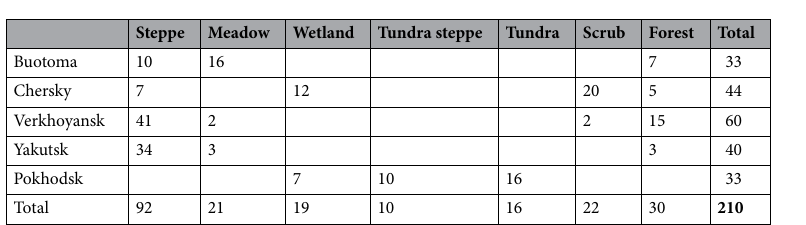
Table 2. Overview on the number of plots in each single study region per vegetation